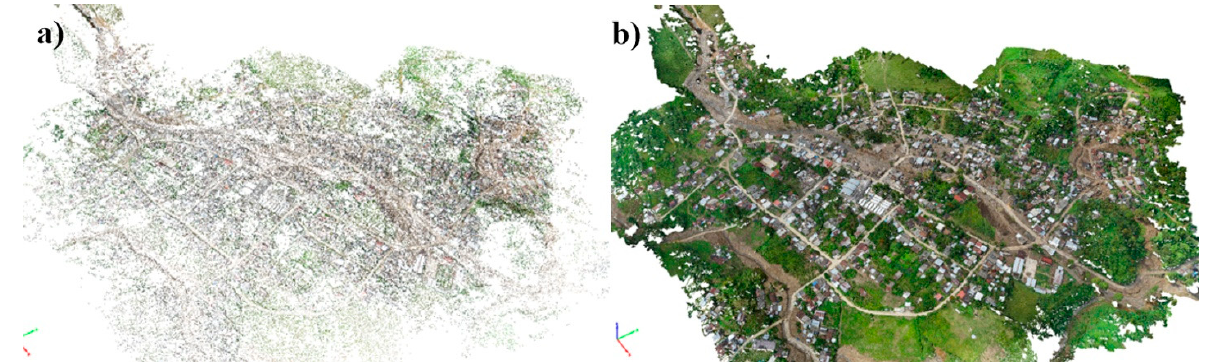
Figure 6. Point cloud: ( a ) sparse and ( b ) dense.